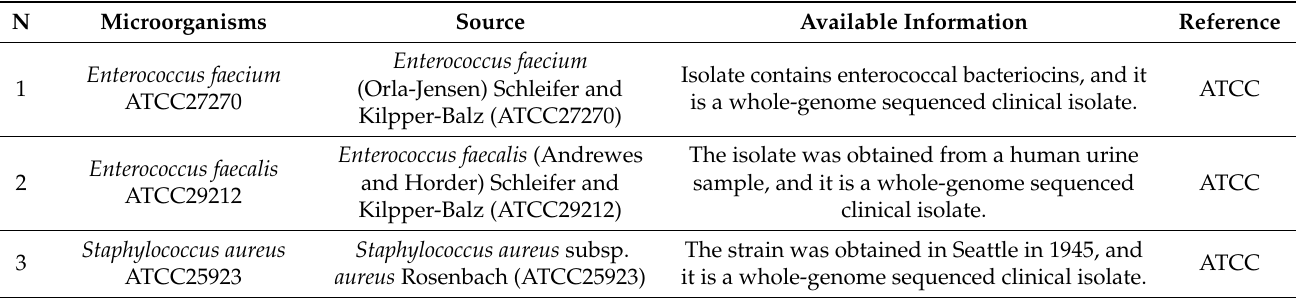
Table 8. List of all micro-organisms used in this study, their sources, and available